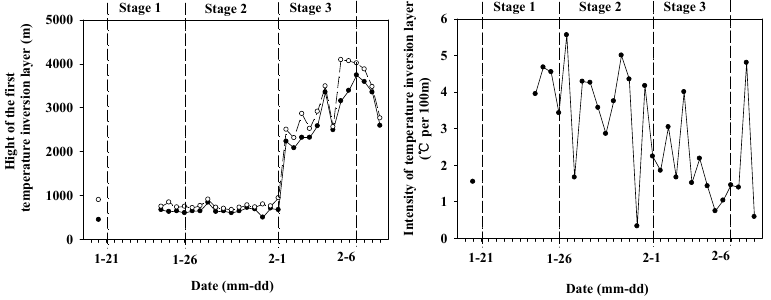
Figure 6. The temporal variation of the height of the bottom and top of the first temperature inversion layer (m), and its intensity (°C per 100 m) in Chengdu during different haze stages at a time interval of 8 h.